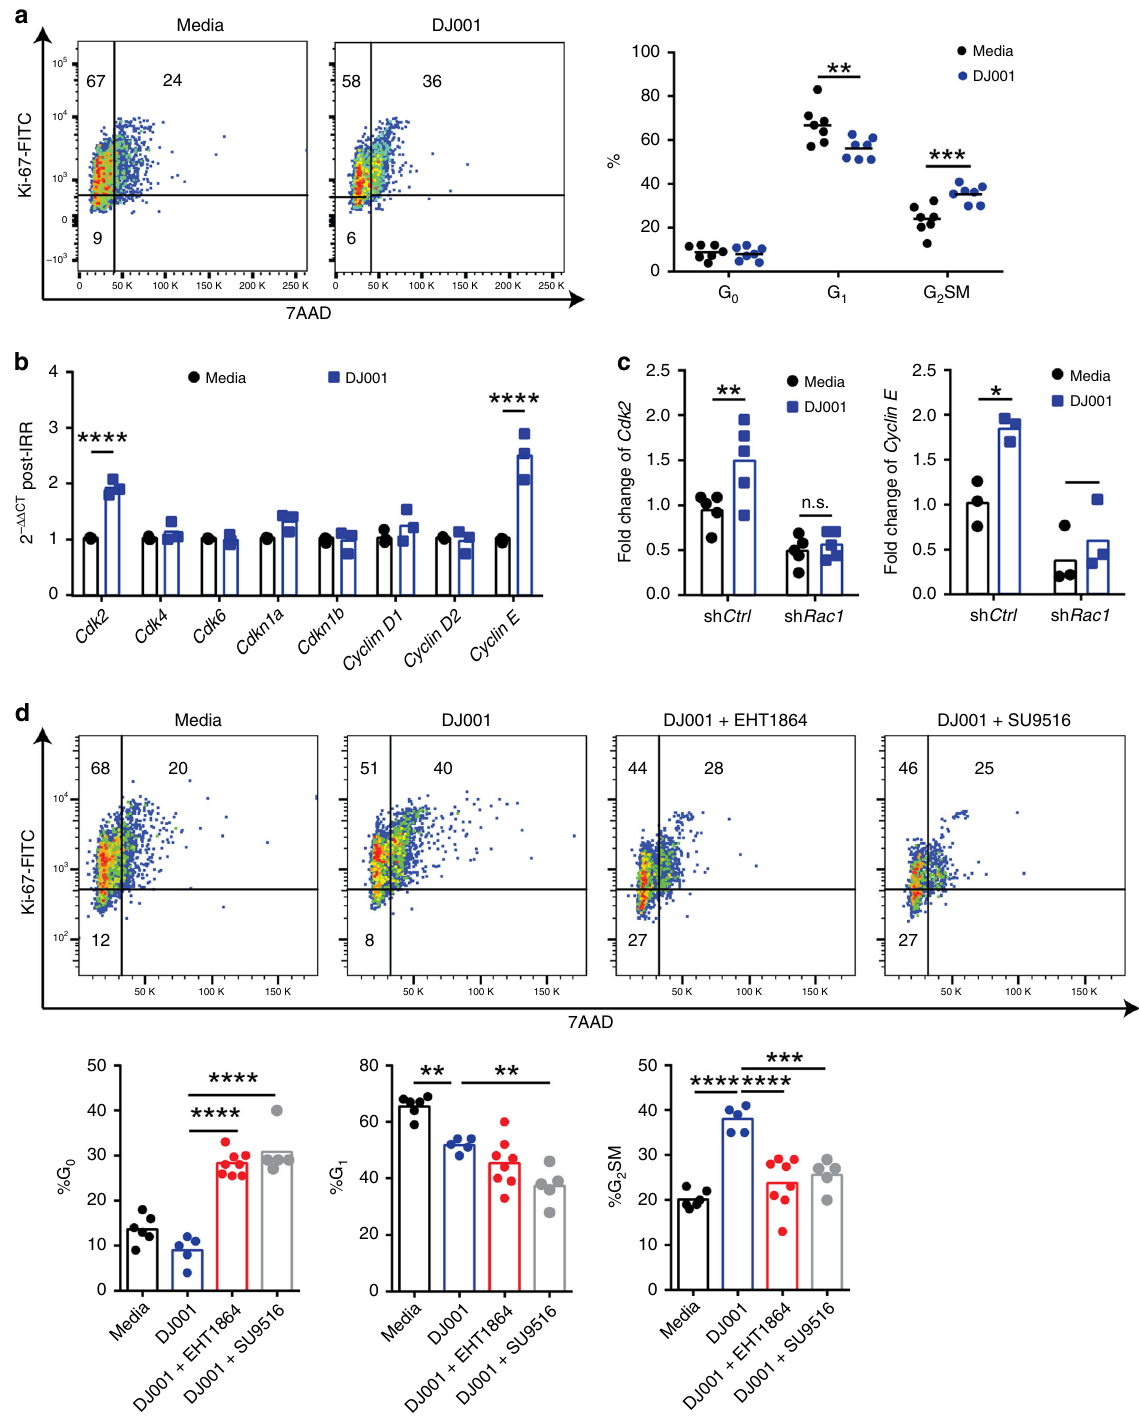
Fig. 4 DJ001 promotes HSC proliferation via induction of CDK2. a At left, representative cell cycle analysis of BM KSL cells at 36 h following 300 cGy and culture with media± 1 μ g/mL DJ001. At right, mean percentages of KSL cells in G 0 (Ki67 − 7AAD − ), G 1 (Ki67 + 7AAD − ) and G 2 /S/M phase (Ki67 + 7AAD + ) are shown ( n = 7). b Fold changes (2 − ΔΔ Ct ) of cell cycle regulatory gene expression in KSL cells at 36 h following 300 cGy and culture with media± DJ001 ( n = 3). Gene transcript changes are normalized to Gapdh and media treatment. c Fold changes (2 − ΔΔ Ct ) of Cdk2 and Cyclin E expression in BM lin − cells in response to DJ001 at 48 h after 300 cGy, with and without Rac1 -shRNA treatment ( n = 3 – 5). d Top panel shows representative cell cycle analysis of KSL cells at 36 h following 300 cGy and culture with media ± 1 µ g/mL DJ001, DJ001 ± 6 µ g/mL EHT1864, and DJ001 ± 240 ng/mL CDK2 inhibitor SU9516. Bottom panel shows the percentages of BM cells in G 0 , G 1 , and G 2 /S/M phase for each condition (media, n = 6; DJ001 and DJ001 + SU9516 groups, n = 5; DJ001 + EHT1864, n = 8). Two-way ANOVA with Sidak ’ s multiple comparison test for a – c . One-way ANOVA with Tukey ’ s multiple comparison test for d . Source data are provided as Source Data File. * P < 0.05, ** P < 0.01, *** P < 0.001, **** P <